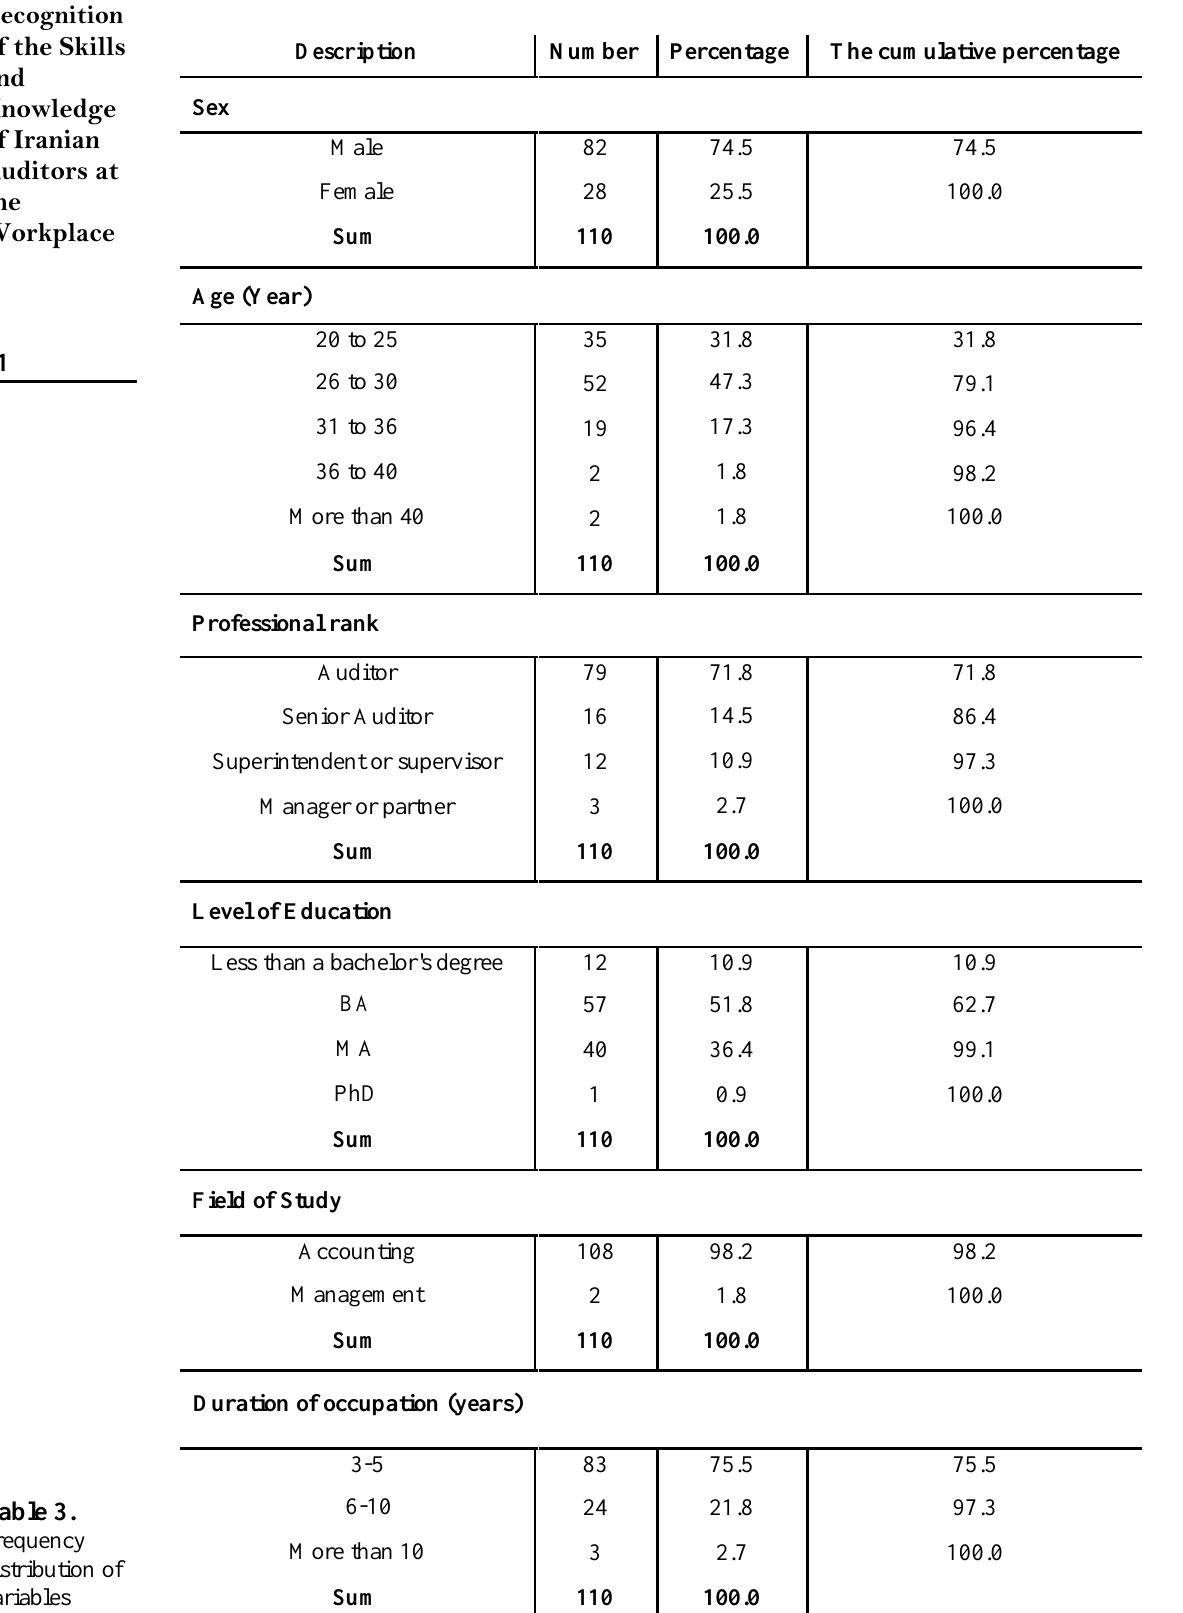
Table 3. Frequency distribution of